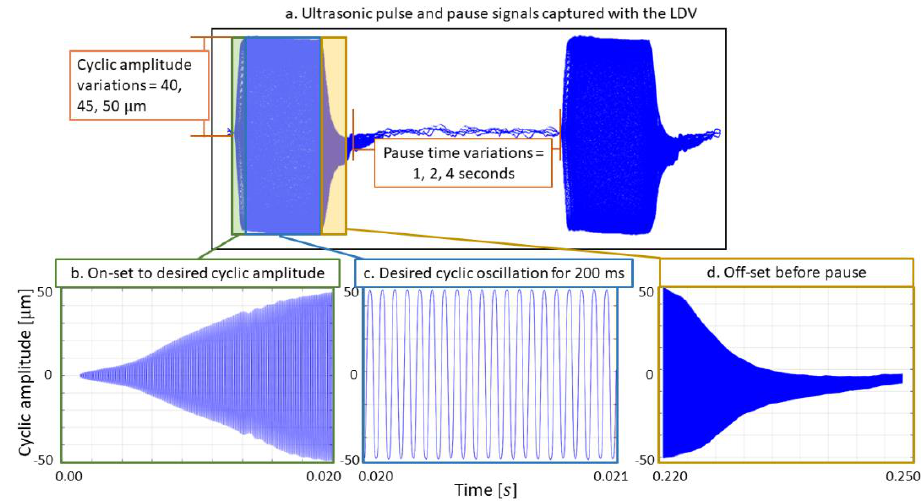
Figure 3. ( a ) A characteristic ultrasonic pulse−pause sequence captured by the LDV; ( b ) the on−set regime (ramp−up) of the pulse; ( c ) the part of the pulse with cyclic amplitude = 50 μ m; ( d ) off−set (ramp−down) regime of the pulse.